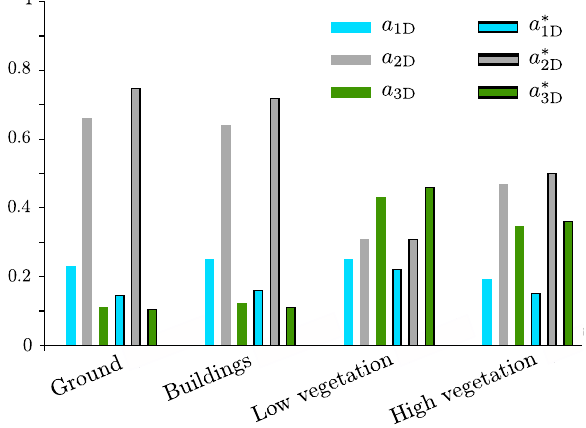
Figure 7: Improvements in shape feature computation using an optimal neighborhood radius per point. a dD and a ∗ feature for dimensionality d , computed with neighborhoods of constant size and adaptive size, respectively. The constant neigh- borhood size corresponds to the 30 nearest neighbors of each